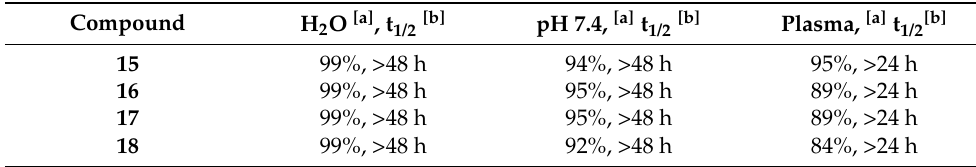
Table 2. Stability tests of compounds 15 – 18 . Compound